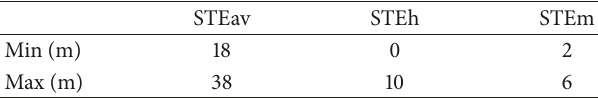
Table 3: Ranges in which the STE parameters are varied.